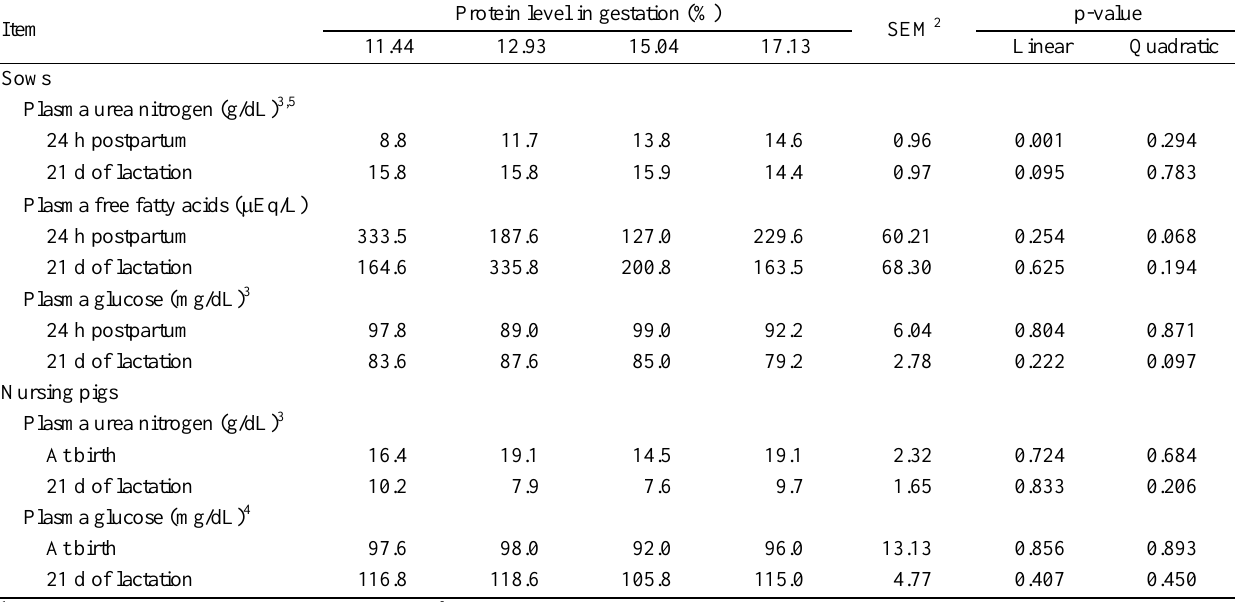
Protein level in gestation (%)